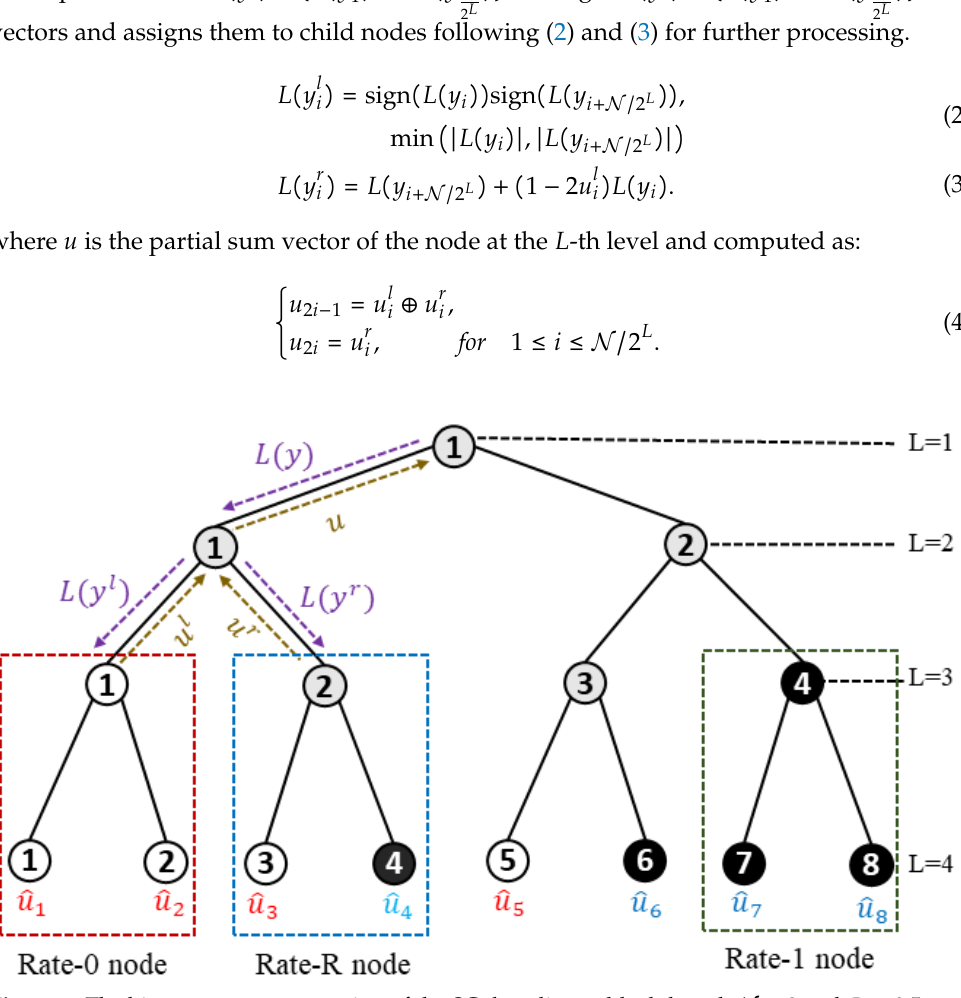
Figure 1. The binary tree representation of the SC decoding at block-length N = 8 and R = 0.5. The u l = { u l , ⋯ , u l } and u r = { u r 1 , ⋯ , u r } are the partial sum vectors resulting 1 N / 2 L N / 2 L from the left and right offspring. The estimated bit ˆ u i can be obtained at the leaf node based on the soft-decision LLR ( L ( ˆ y i ) ) using